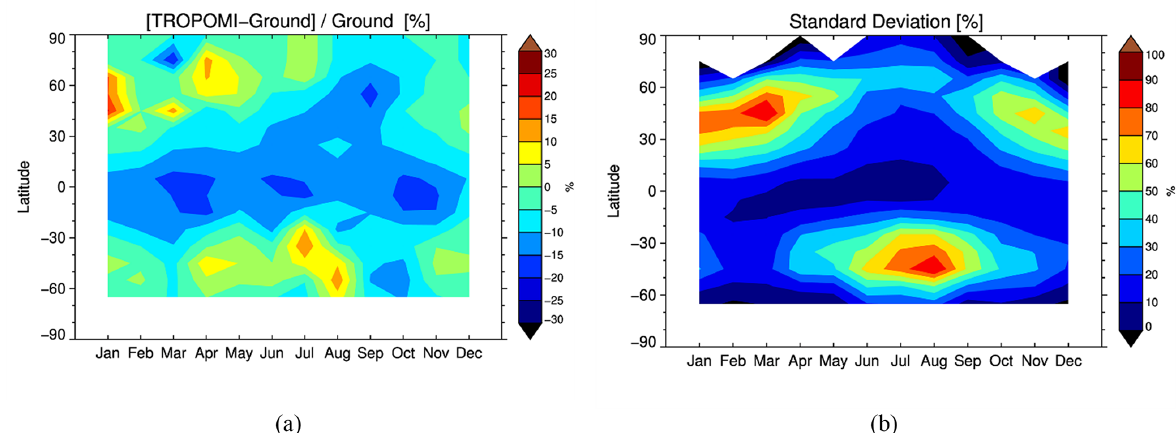
Figure 8. The seasonal and latitudinal variability of (a) the mean relative differences between satellite- and ground-based TCWV observations and (b) the respective standard deviations (in %).